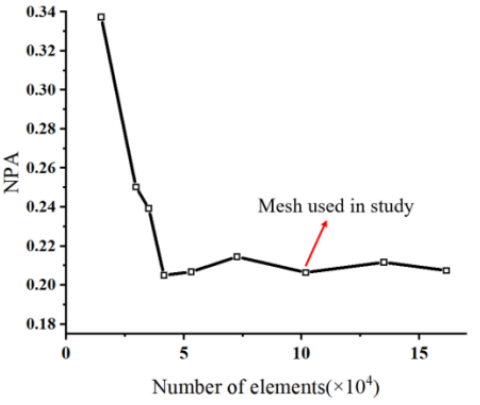
Figure 4. The relationship between the number of elements and NPA.